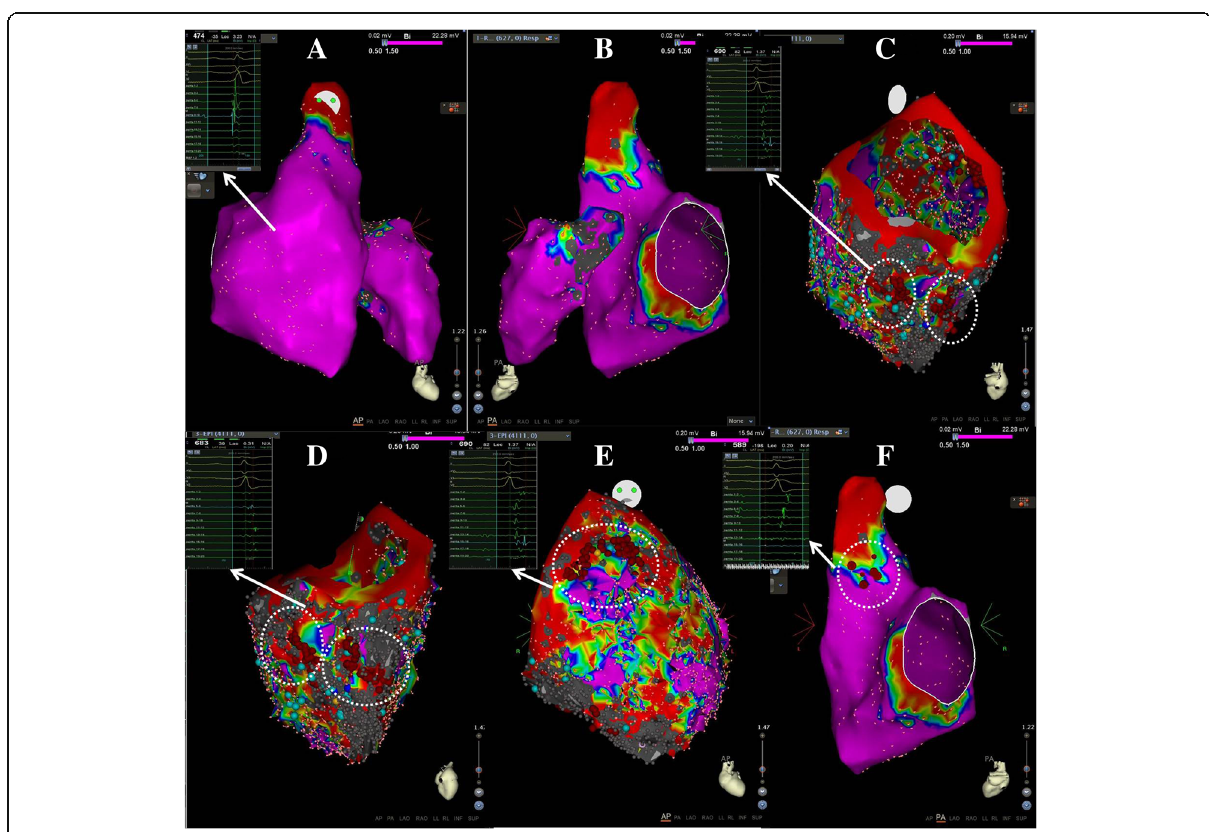
Fig. 5 Electrical and anatomical mapping with guidance of CARTO system. a Endocardial mapping of both ventricles, showed in anterior-posterior position. b Endocardial mapping of both ventricles, showed in posterior – anterior positions. c – d Epicardial mapping indicated that there were obvious low-voltage regions or scars with significant late, double or fragmented potentials, around the tricuspid annulus, in inferior-lateral-apex and inferior-apex walls ( c – d ), and outflow tract ( e ) of right ventricle. Line and lamellar ablation was performed across the scars (red points). F, in the mid-septum of endocardium in the right ventricle, the pacing mapping suggested potential targets, as ECG characteristics of pacing similar to that of short episodes of clinical VT. This region was mapped with significant late potentials and ablated (red